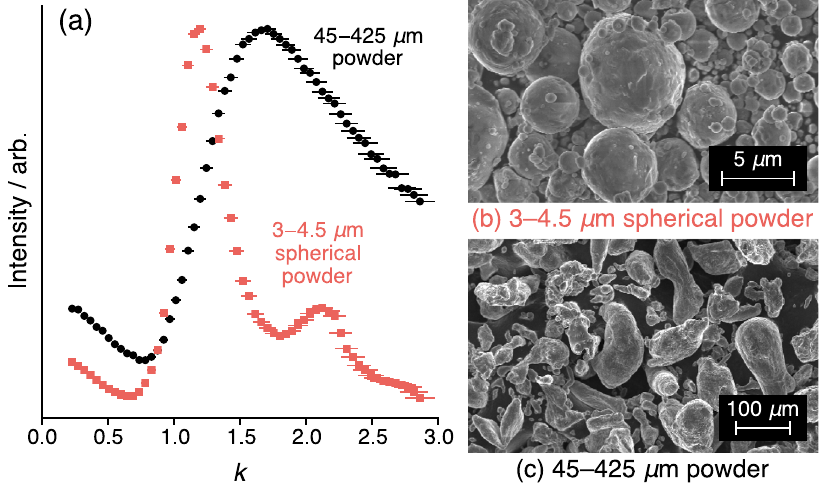
Figure 6. Experimental results obtained on powdered aluminium samples by ( a ) varying k (using a fixed pulse width, τ π /2 = 11 μ s and changing the pulse power, with the k = 1 pulse power calibrated with a 1 M Al(NO 3 ) 3 solution) in the pulse sequence shown in Fig. 2 with N = 8 and Δ = 80 μ s. The intensities of the on- resonance positions in the spectra are plotted. Error bars are calculated following the methodology described in the caption to Fig. 5. Where errors are not visible, they fall within the marker size. ( b , c ) SEM images of the two samples. The second peak at higher k -value for the smaller particles is likely a consequence of the n = 2 overtone signal, which is due to the fact that the particle size is < δ /4. As a result, signals from regions experiencing a readout pulse slightly larger and smaller than π do not cancel each other